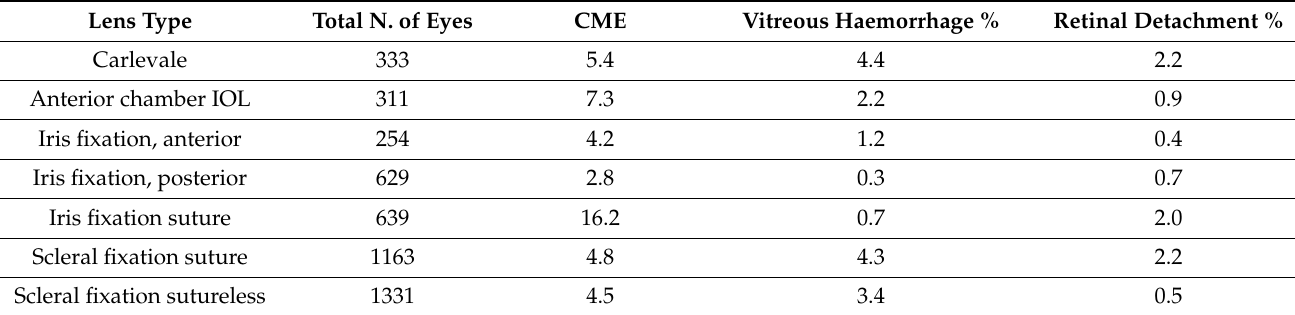
Table 3. Intraocular lens weighted complication means.